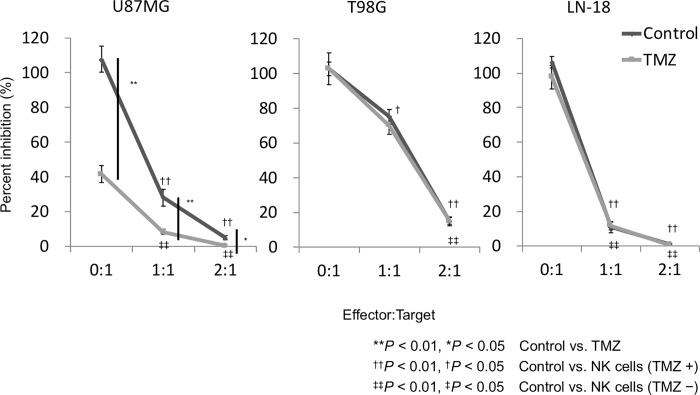
Growth inhibition effects of GiNK and TMZ on GBM cell lines in vitro.GBM cell lines were seeded at 2×104 cells/well in 24-well flat-bottomed plates in the presence of GiNK at a GiNK:GBM cell ratio of 0:1, 1:1, or 2:1 and cultured for 96 h. Diamond and square marks, the absence and presence of 50 μM TMZ, respectively. Adherent cells were detached and determined by trypan blue exclusion. Non-stained cells were counted as viable cells. Left, center, and right graphs, U87MG, T98G, and LN-18 cells, respectively. Data indicated as mean ± SE of nine independent experiments. P values were determined using the Kruskal–Wallis test followed by Steel–Dwass’s test. Statistically significant differences: **P < 0.01, *P < 0.05, control versus TMZ; ††P < 0.01, †P < 0.05, control versus NK cells (in the presence of TMZ); ‡‡P < 0.01, ‡P < 0.05, control versus NK cells (in the absence of TMZ).